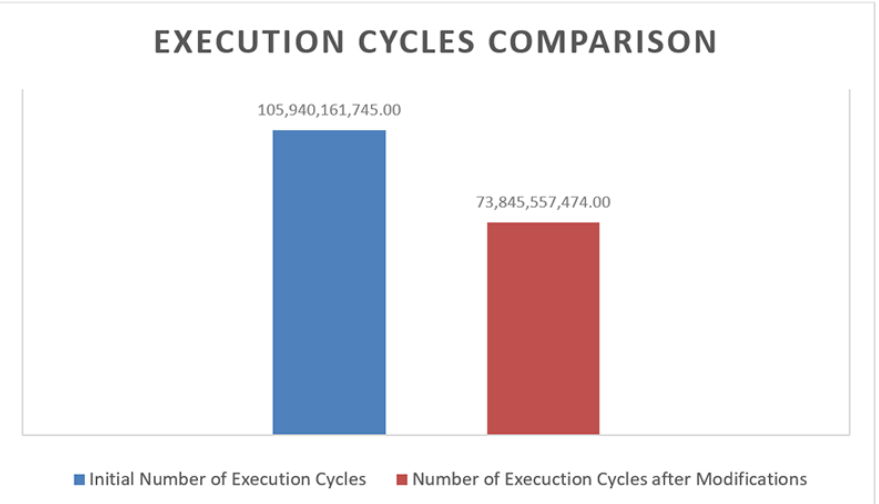
Figure 5. Kalign execution cycles acceleration.